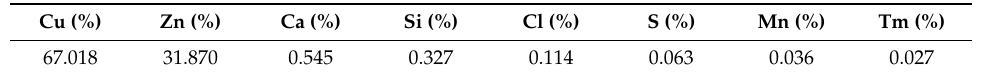
Table 5. Chemical composition by weight (wt %) of the fixed contact at the “Cut Y” point of Figure 6b according to the chemical analysis test.